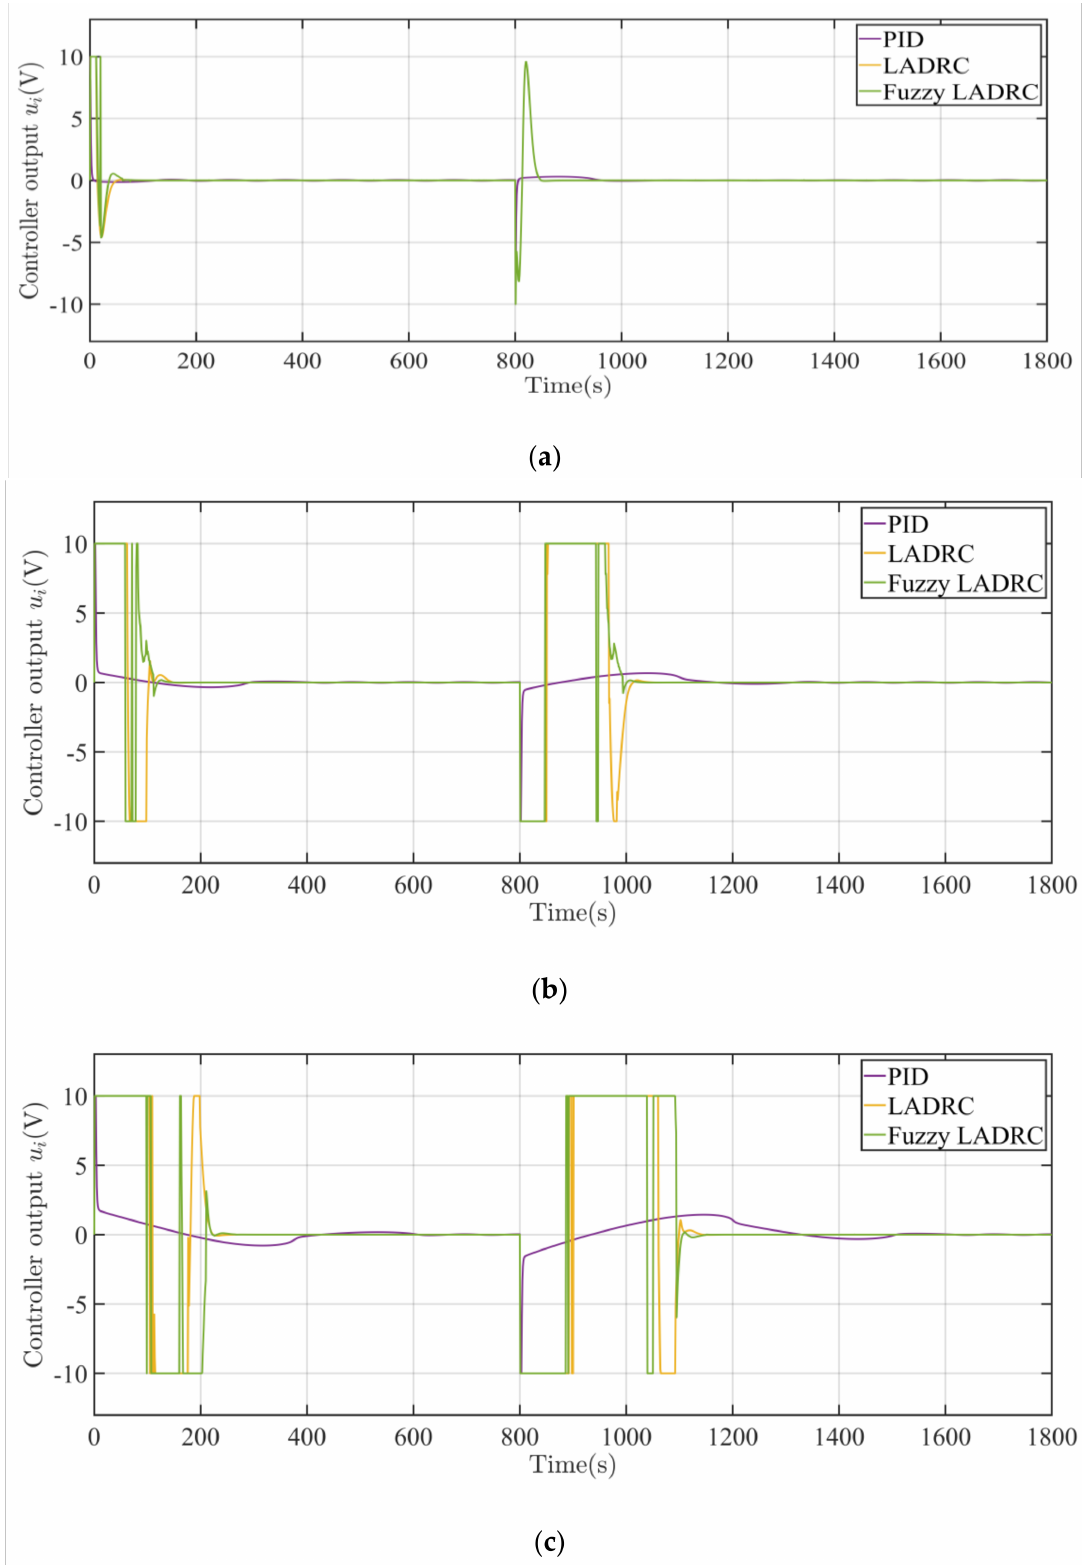
Figure 7. Controller outputs of different target depths corresponding to Figure 6a–c. ( a ) δ d = − 4990 m. ( b ) δ d = − 4950 m. ( c ) δ d = − 4900